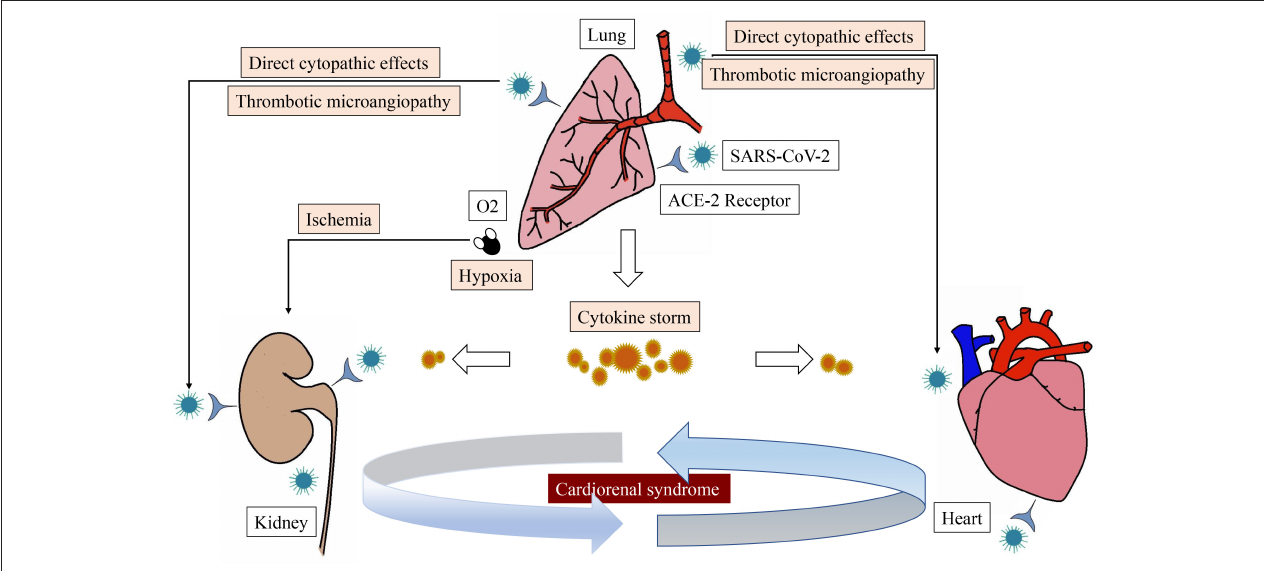
FIGURE 2 | The main pathophysiological pathways of cardiorenal syndrome associated with SARS-CoV-2 infection.